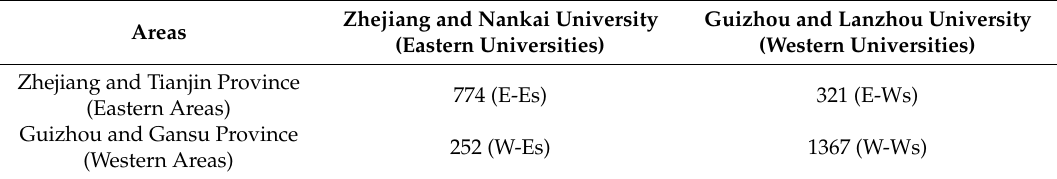
Table 1. The distribution of undergraduate students ( n = 2714).